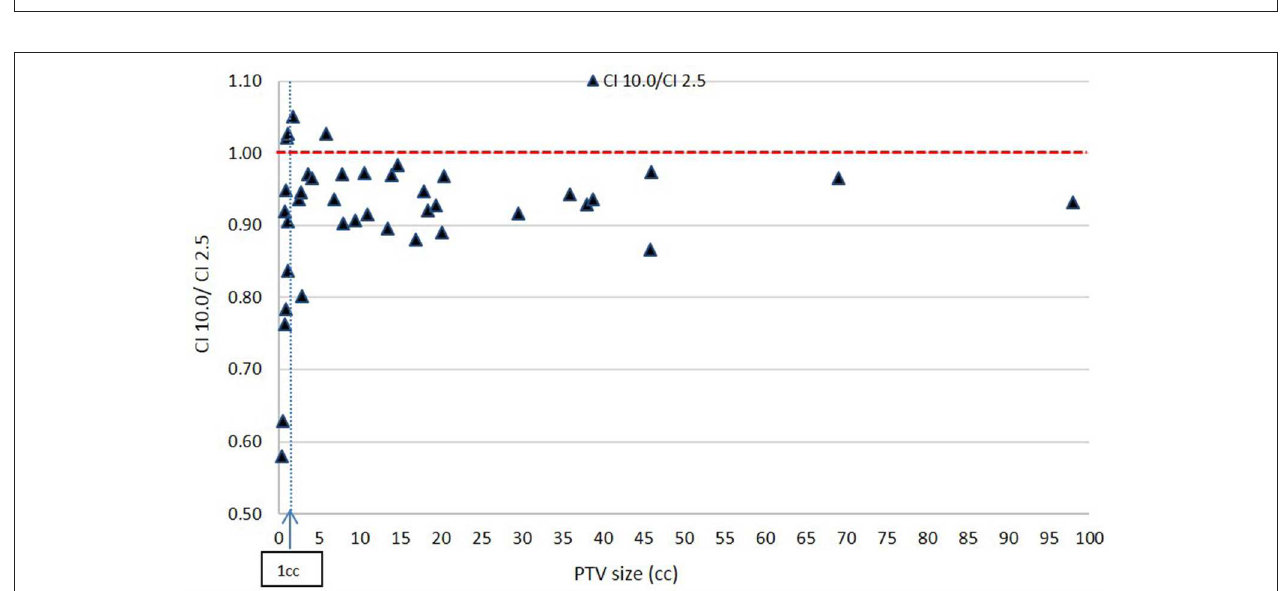
FIGURE 7 | Ratio of Conformity Indices CI 10.0 to CI 2.5 as a function of PTV size.